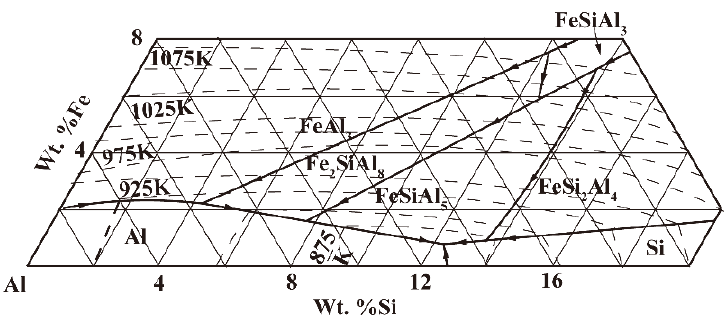
Figure 2. Liquidus surface in the Al corner of the Al–Si–Fe system [10].